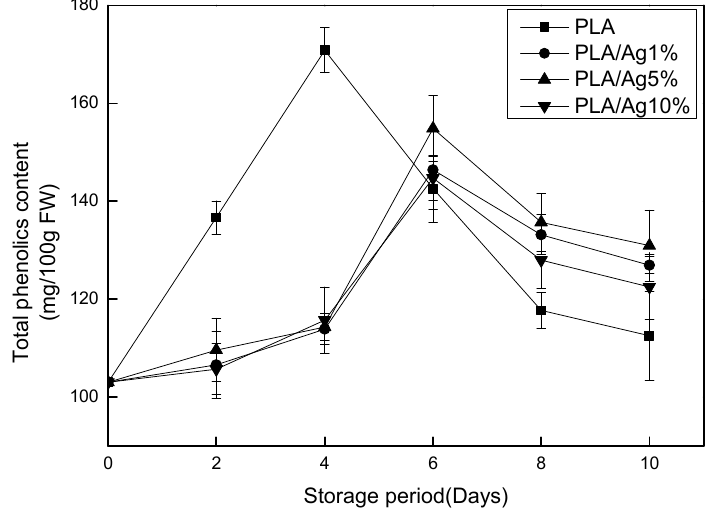
Figure 8. Effect of different concentration of nano-Ag active packages on total phenolics of strawberry stored at 4 ± 1 °C for 10 days. Data are presented as mean ± standard deviation.